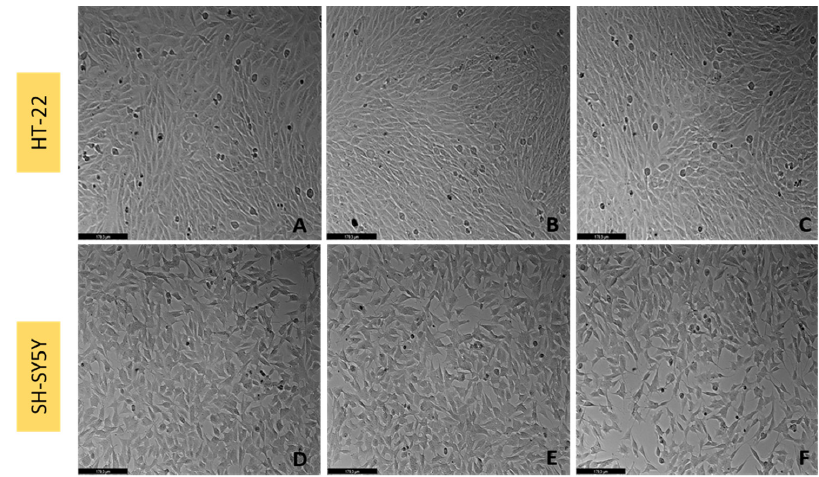
Figure 12. Representative images (100 × total magnification) of HT-22 and SH-SY5Y cells after incu- bation of increasing concentrations of L-tryptophan. Cells were treated with ( A , D ) vehicle (1% ster- ilized water) ( B , E ) L-tryptophan 0.1 nM, ( C , F ) L-tryptophan 100 μ M.